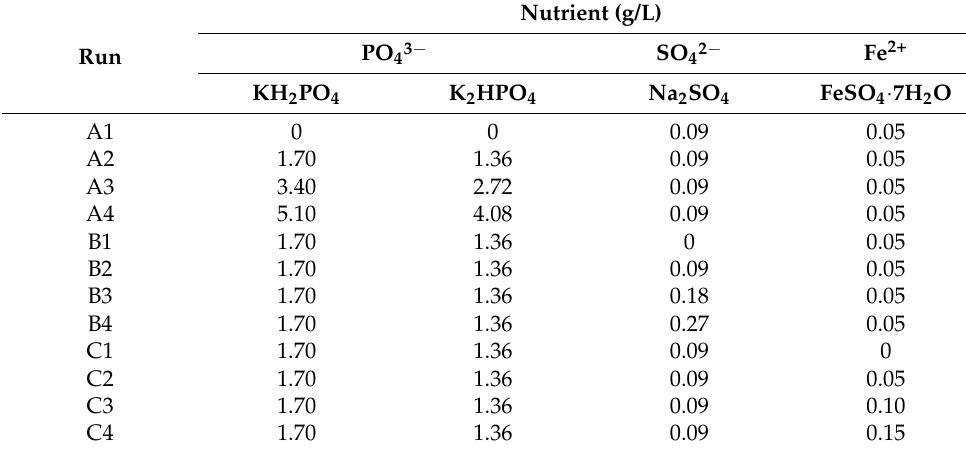
Table 1. Concentration variation of PO 43 − , SO 42 − , and Fe 2+ for preliminary